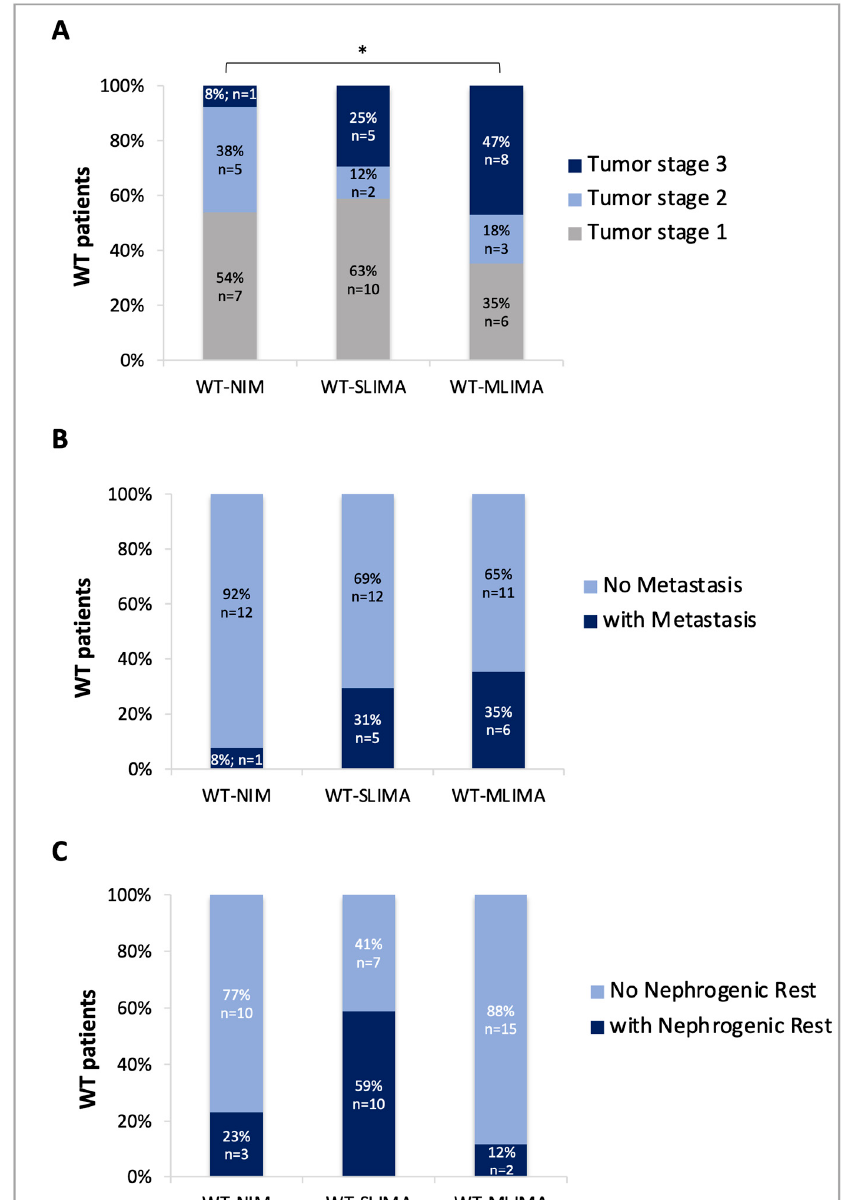
Figure 2. Correlation between epigenotype and phenotype. Distribution of the tumor stages ( A ), metastasis ( B ), or nephrogenic rest ( C ) for 47 patients of which clinical information was available. WT-MLIMA, patients with multilocus imprinted methylation aberrations; WT-SLIMA, patients with single-locus imprinted methylation aberrations; WT-NIM, patients with normal imprinted methylation. * p less than or equal to 0.05, chi-square